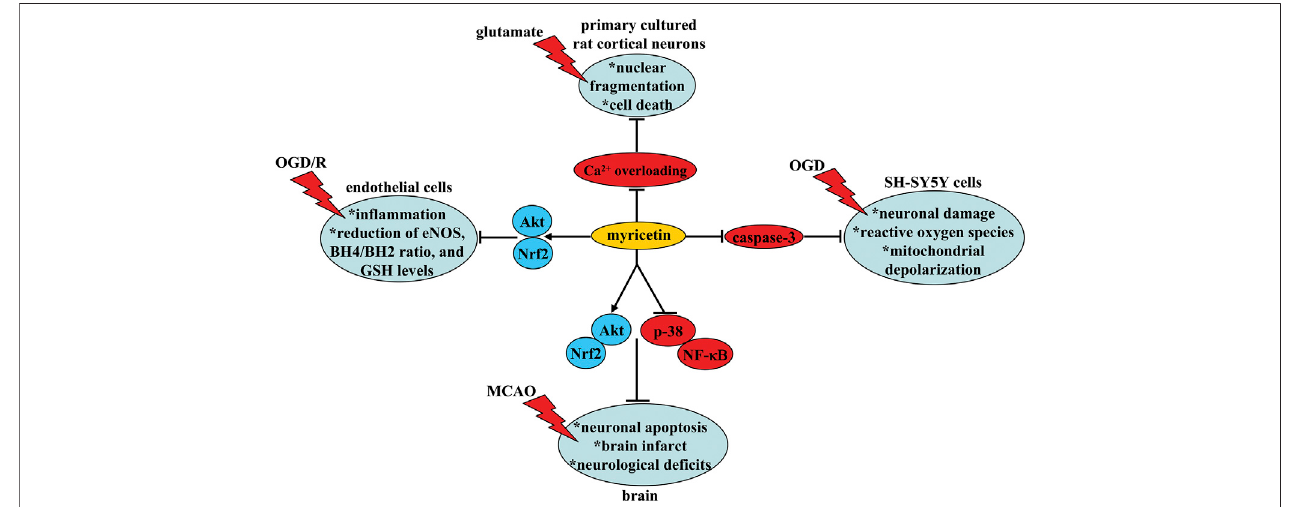
FIGURE 2 | Neuroprotective effects and possible mechanisms of myricetin in models of cerebral ischemia. Myricetin inhibits (i) OGD/R-induced in fl ammation, decrease in eNOS expression, phosphorylation, and activity, decrease in intracellular BH4/BH2 ratio, and decrease in intracellular GSH levels in endothelial cells via stimulation of Akt and Nrf2, (ii) glutamate-induced nuclear fragmentation and cell death in primary cultured rat cortical neurons via suppression of Ca 2+ overloading, and (iii) OGD-induced neuronal damage, reactive oxygen species production, and mitochondrial depolarization in SH-SY5Y cells via inhibition of caspase-3. Myricetin administration can also reduce neuronal apoptosis and infarct area and improve neurological de fi cits in a rat model of MCAO via increasing Akt activity, decreasing p38 and NF- κ B activity, and increasing Nrf2 nuclear translocation.